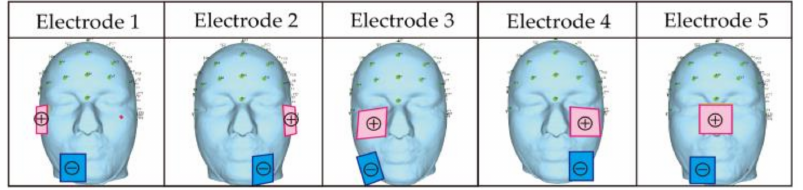
Figure 4. Electrode placements for the stimulation of the lower eyeball surface; figures were produced by the authors using SimNIBS (29 September